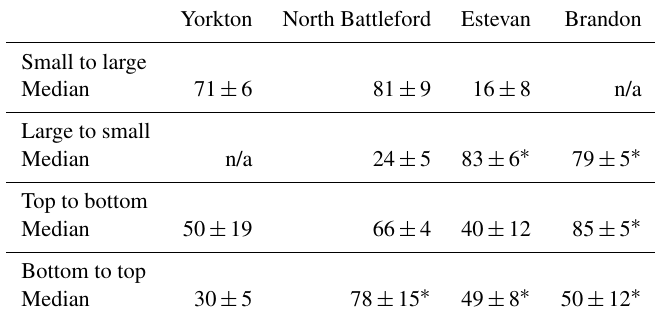
Table 6. Drainage thresholds (with standard error), where breakpoints indicate a difference in the rate of change in annual median runoff. Note: n/a is not applicable.